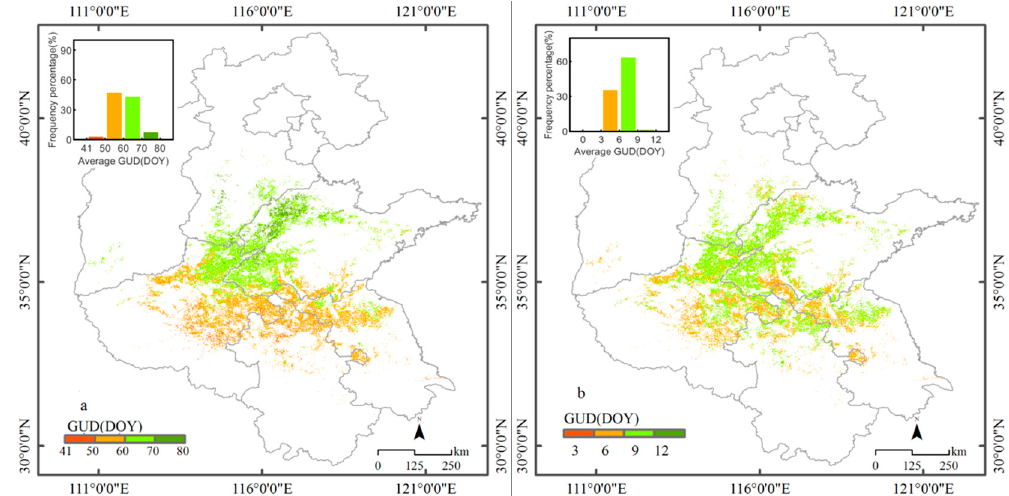
Figure 4. Spatial distribution of multiyear averaged GUD ( a ) and its Standard deviation ( b ) during the period of 2001–2015. Inset plots display the corresponding frequency distribution.